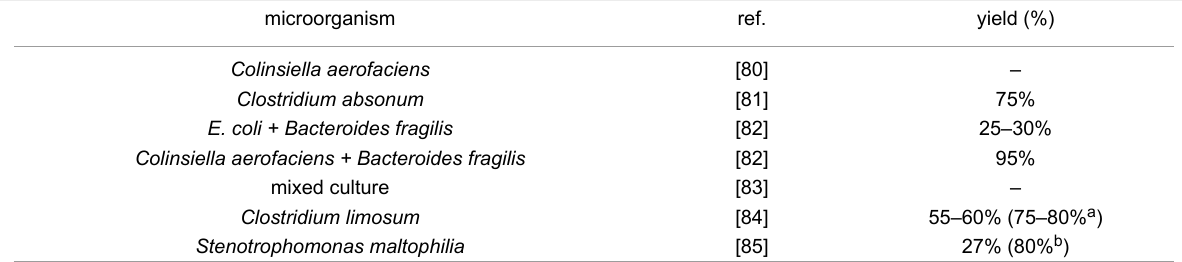
Table 4: Summary of reported whole-cell transformations with wild type microorganisms. Epimerization yields of CDCA to UDCA are given. microorganism